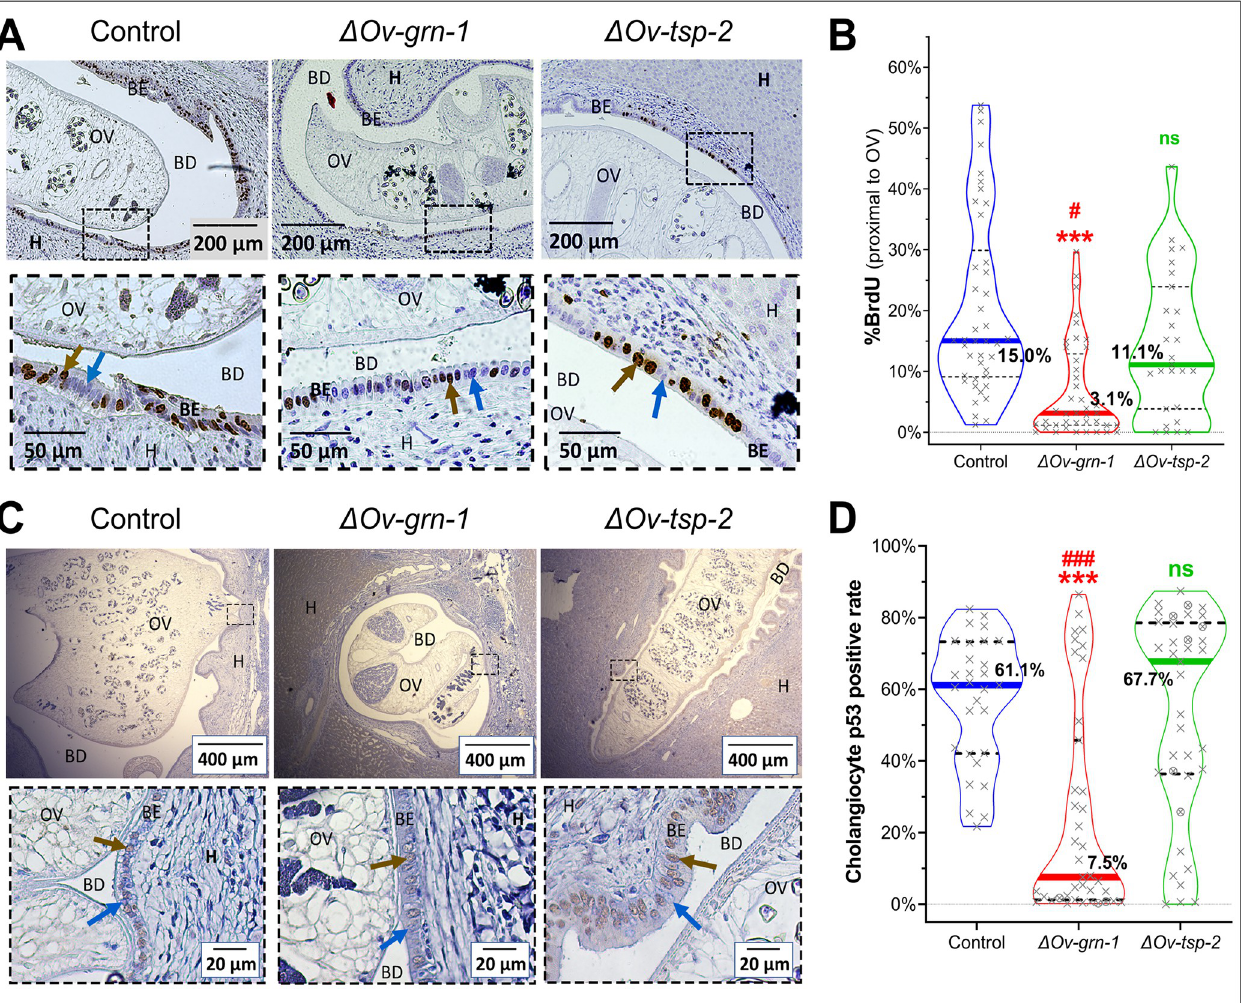
Fig 7. Reduced proliferation and minimal mutant p53 expression in cholangiocytes in hamsters infected with Δ Ov-grn-1 genotype liver flukes. Representative images of biliary cells that incorporated BrdU from regions proximal to flukes in control, Δ Ov-grn-1 and Δ Ov-tsp-2 groups (A) . The boxed region in the upper image is expanded in the lower panel. The brown arrow highlights the positive BrdU-stained nuclei and the blue arrow highlights a bile duct cell that did not incorporate BrdU. BrdU index measured from cholangiocytes adjacent to where a fluke was located (n = 27 to 42 per group). (B) . Representative micrograph of p53 immunohistochemical staining of biliary epithelium during infection with gene edited flukes (C) . Anti-mutant p53 antibody stained the nuclei brown (brown arrows); blue arrows indicate negative cells. Black dashed box in upper wide-angle image magnified in the lower image to aid visualization. Positivity rate (percentages) of mutant p53-positive cholangiocytes (n = 29 to 39 images per group) (D) . Where available, 500 to 800 cells were scored from sections of each of the left, middle, and right lobes of the liver marked by “X”. Fewer cholangiocytes (300–500) were available for assessment in several samples, denoted by ⓧ Panels A and C: OV = Opisthorchis viverrini , H = hepatocytes, BD = bile duct, BE = biliary epithelium. Panels B, D: non- parametric Kruskal-Wallis test with Dunn’s multiple comparison correction compared against control: ns = not significant; ��� , P � 0.001, or against Δ Ov-tsp- 2 : #, P � 0.05; ###, P � 0.001. Thick colored lines signify the median and the dashed black lines denote the inter-quartile range.